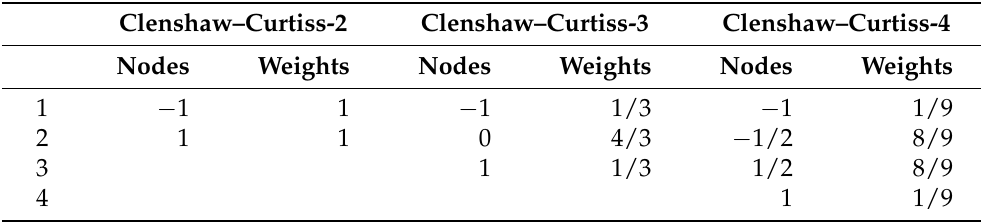
Table A1. Nodes and weights of the Clenshaw–Curtis quadrature formulas of order 2, 3, and 4 on the interval [ − 1,1 ] .